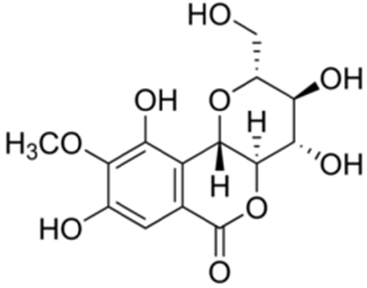
Figure 1. Structure of bergenin.